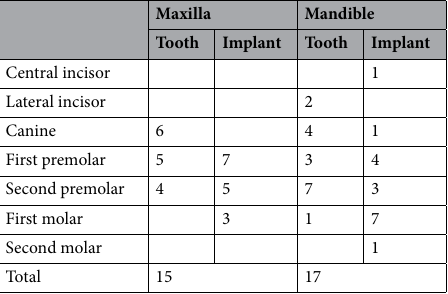
Table 2. Location and incidence of affected tooth/implant.